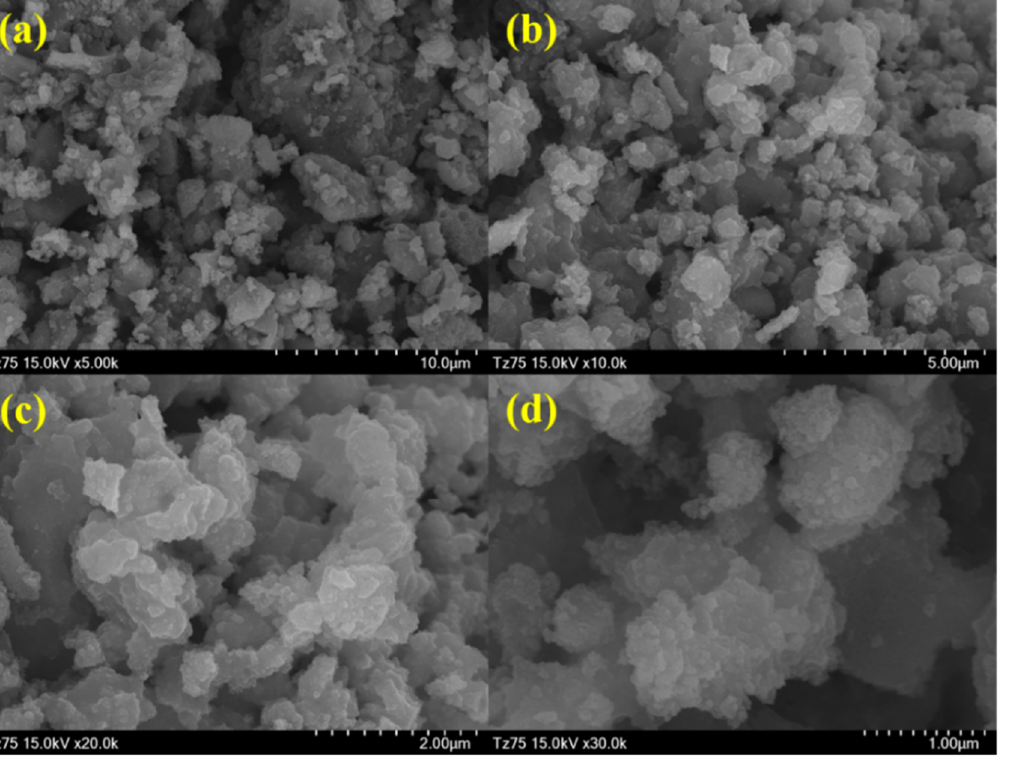
Figure 2. SEM images of ( a – d ) TZU75 nanocomposite.